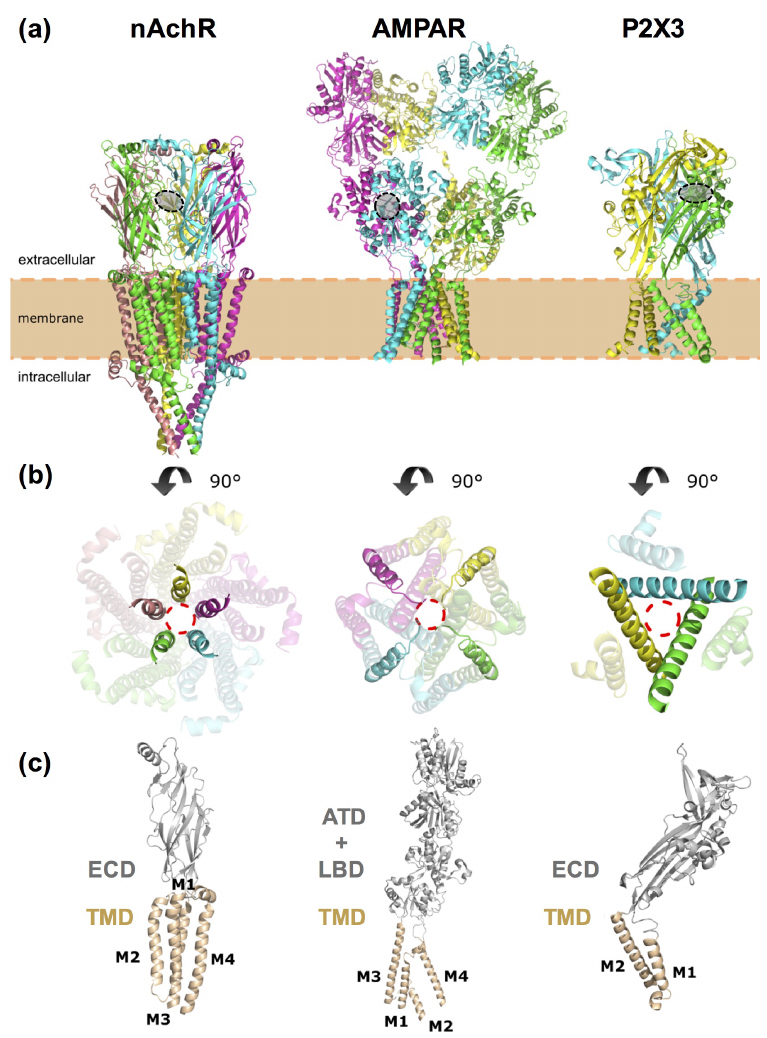
Figure 5. Representative structures of the three ligand-gated ion channel (LGIC) classes. ( a ) Shown from left to right, structures of a pentameric ligand-gated ion channel (pLGIC) based on the nicotinic acetylcholine receptor (nAchR), PDB code 7EKI [66]; an ionotropic glutamate receptor (iGluR), based on the AMPA receptor, PDB code 3KG2 [67]; and an ATP-gated purinergic (P2X) receptor, PDB code 5SVL [68]. Each protein subunit is shown in a different color (yellow, pink, green, cyan and/or magenta). A gray circle indicates the orthosteric binding site of LGICs, where the agonists or antagonists used to design most of the PCLs and PTLs mentioned in the text bind. For the sake of clarity, only one of the symmetric sites of the homomeric receptor is shown (out of the five present in nAchR, four in AMPAR and three in the P2X3 receptor). ( b ) Transmembrane domain (TMD) viewed from the extracellular side. The pore-lining structural elements are displayed in solid colors (i.e., the M2 helix for the nAchR and P2X3 receptors or the M2 helix and the re-entrant pore-loop for AMPAR) and the ion-conducting pore is indicated with a red dashed circle. ( c ) Detailed view of one subunit. The extracellular domains (ECD) of both the nAChR and P2X3 receptors are colored in gray, whereas the transmembrane domain (TMD) is colored in apricot. The AMPAR is displayed with the same color scheme, but the extracellular part of the receptor is divided into an amino terminal domain (ATD) and a ligand binding domain (LBD). Transmembrane helices are labeled from M1 to M4 or from M1 to M2, respectively. The intracellular domain is not shown for the sake of